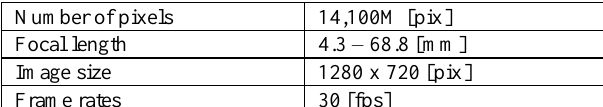
Figure 6. Target example Table 1. Video camera specifications